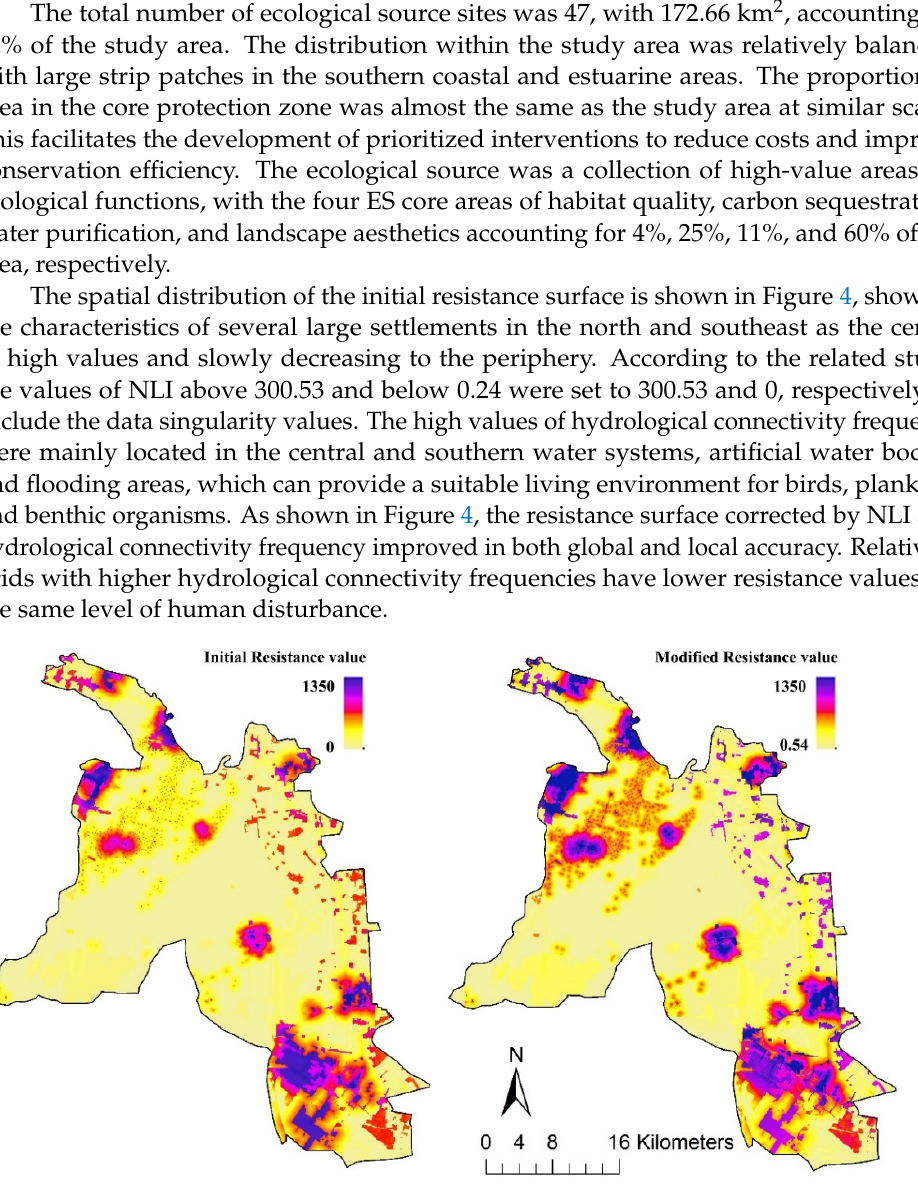
Figure 4. Spatial distribution of initial resistance surface and modified resistance surface.